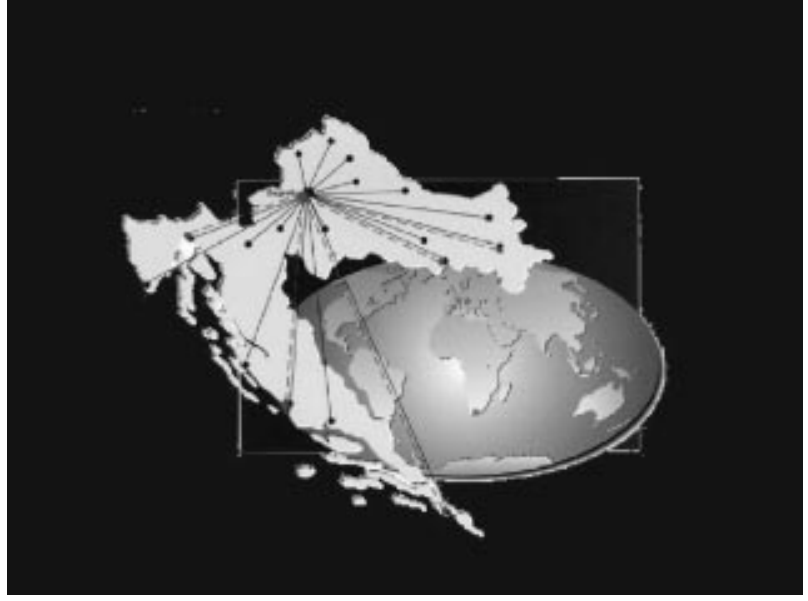
Fig. 3. Telepathology and teleradiology networks in